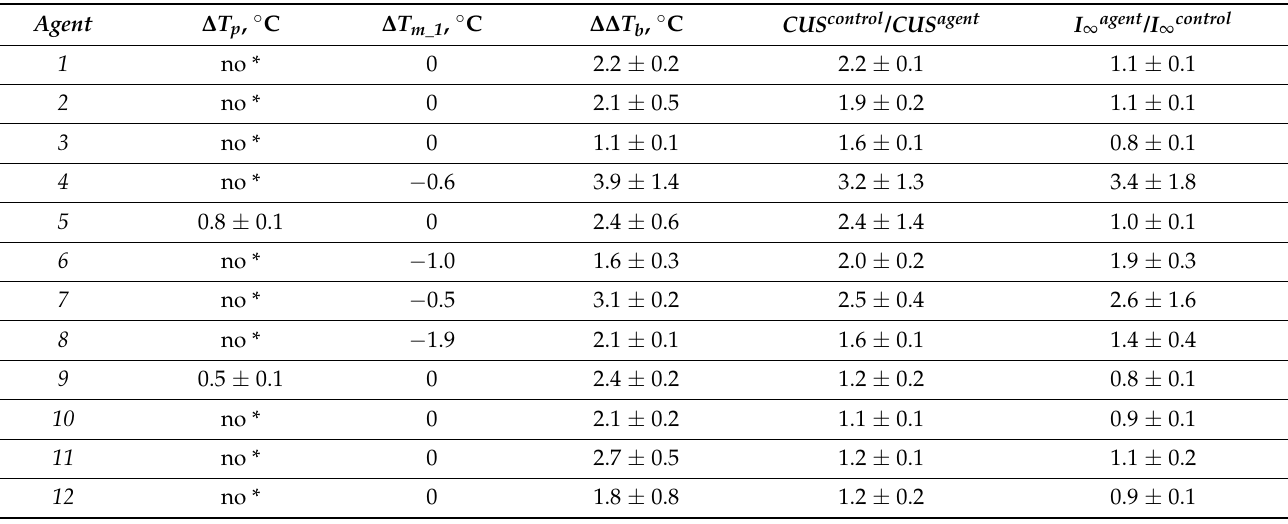
Figure 4. Heating thermograms of DPPC liposomes in the absence and presence of various chromone-containing allylmorpholine derivatives at 100 µg/mL. ( A ) control, 1 , 2 , 3 , 4 , 5 , and 6 ; ( B ) 7 , 8 , 9 , 10 , 11 , and 12 . The relationship between the profile and the compound is given in the figure. Table 2. Parameters characterizing the effects of chromone-containing allylmorpholines at 100 µ g/mL on thermotropic behavior of DPPC and the pore-forming ability of amphotericin B in POPC/CHOL